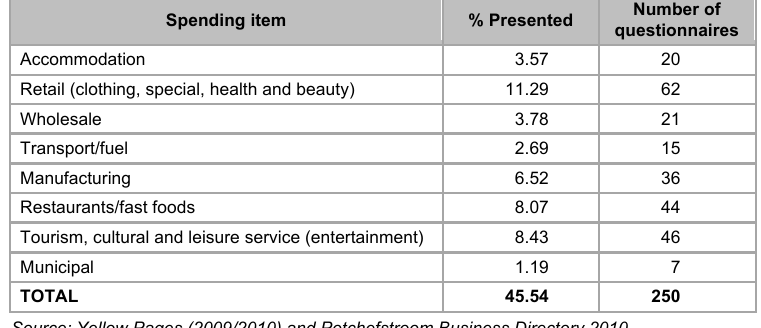
Potchefstroom businesses sector representation and sample